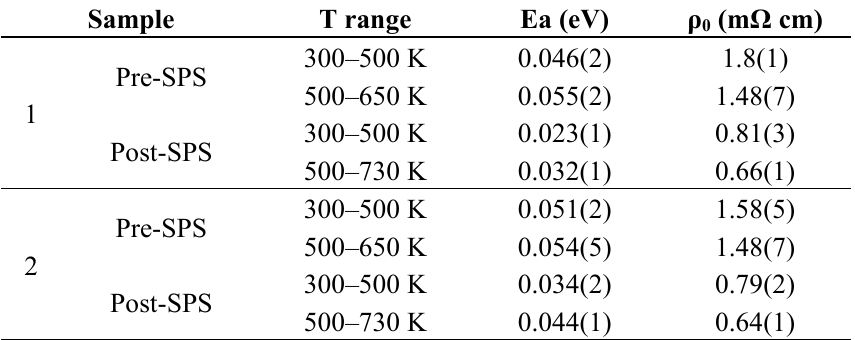
Table 3. Activation energy (E a ) and exponential pre-factor (ρ 0 ) for the Ti 0.5 Zr 0.5 NiSn samples, as determined by an Arrhenius-fit to the resistivity data (see Figure 3).